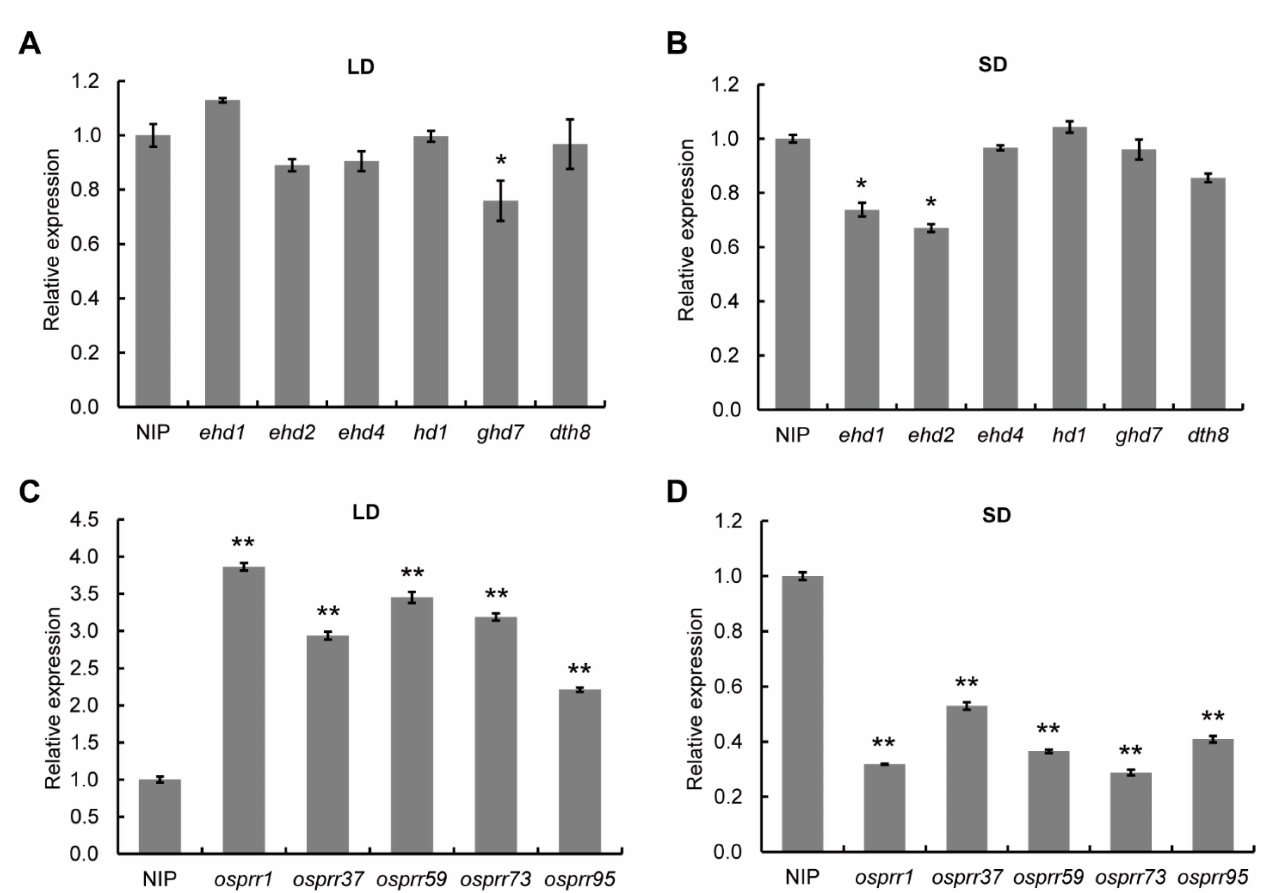
Figure 6. Expression analysis of DHD3 in mutants related to heading stage. ( A , B ) DHD3 expression levels in WT Nipponbare and ehd1 , ehd2 , ehd4 , hd1 , ghd7 , and dth8 mutants under LD and SD conditions. ( C , D ) DHD3 expression levels in WT Nipponbare and osprr1 , osprr37 , osprr59 , osprr73 , and osprr95 mutants under LD and SD conditions. Data are means ± s.e. of three biological replications. Statistical significance is indicated by * p ≤ 0.05 and ** p ≤ 0.01; one-way ANOVA test with Tukey